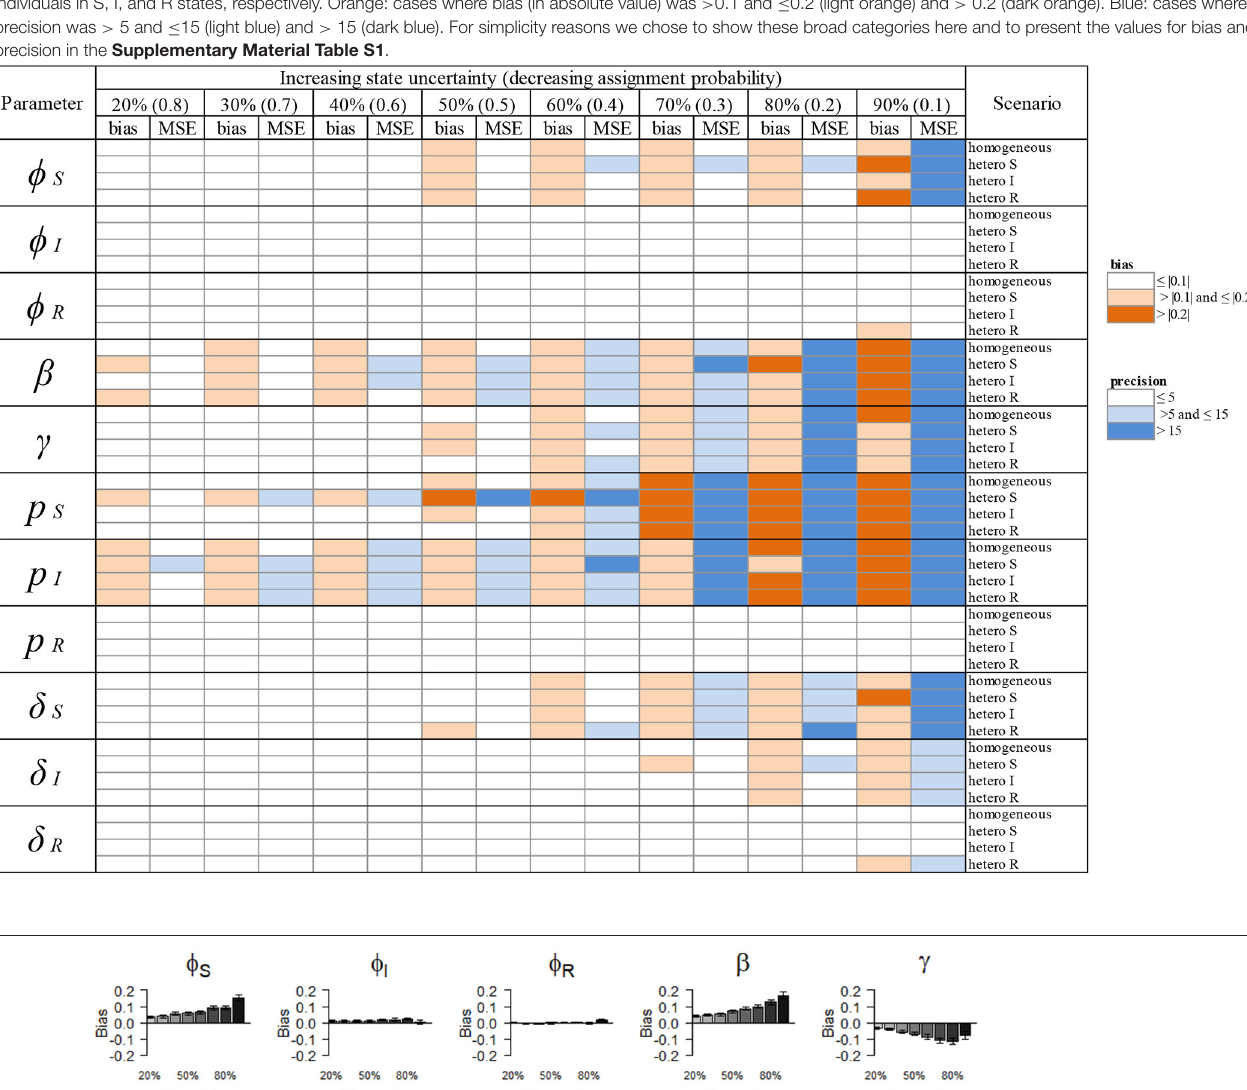
TABLE 2 | Overview of variation in bias (mean difference between the parameter value estimated via simulations and the input parameter value) and precision (minimum squared error, MSE) of parameter estimates in relation to an increasing infection state uncertainty (ranging between 20 and 90%) implemented as a decreasing assignment probability of infection states (ranging between 0.8 and 0.1). Bias and precision were calculated in data sets simulated under different scenarios of assigning infection states: homogeneous or heterogeneous assignment probabilities, in which the assignment of S (“hetero S”), I (“hetero I”) or R (“hetero R”) states was reduced by 50% in comparison to the two other infection states. We used the following notations for the parameters: φ S , φ I and φ R for the survival probability of individuals in S, I, and R states, β for the infection probability, γ for the recovery probability, p S , p I and p R for the detection probability and δ S , δ I and δ R for the assignment probability of individuals in S, I, and R states, respectively. Orange: cases where bias (in absolute value) was > 0.1 and ≤ 0.2 (light orange) and > 0.2 (dark orange). Blue: cases where precision was > 5 and ≤ 15 (light blue) and > 15 (dark blue). For simplicity reasons we chose to show these broad categories here and to present the values for bias and precision in the Supplementary Material Table S1 .